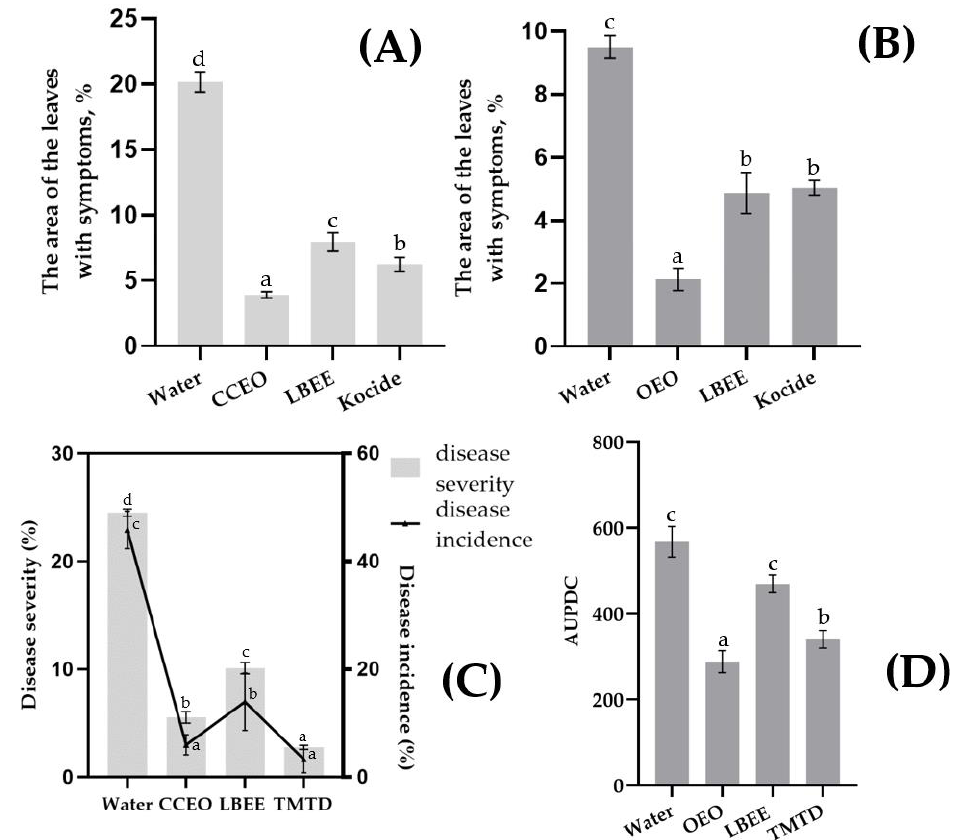
Figure 3. Bacterial blight ( A , C ) and bacterial tan spot and wilting ( B , D ) of soybean caused by artificial inoculation of Psg and Cff under EOs and PE treatment. Values in panels represent the respective mean of three independent trials and error bars represent the standard deviation. Values within columns marked by different letters have a significant difference, Duncan ’ s criteria, p = 0.05. ( A ): disease severity (diseased leaf area %) on green plants inoculated by Psg or ( B ) inoculated by Cff; ( C ): disease severity (diseased leaf area %) (Left vertical scale, Bars) and disease incidence, % (right vertical scale, line), after soybean seed inoculation by Psg; ( D ): values of AUPDC after soybean seed inoculation by Cff.